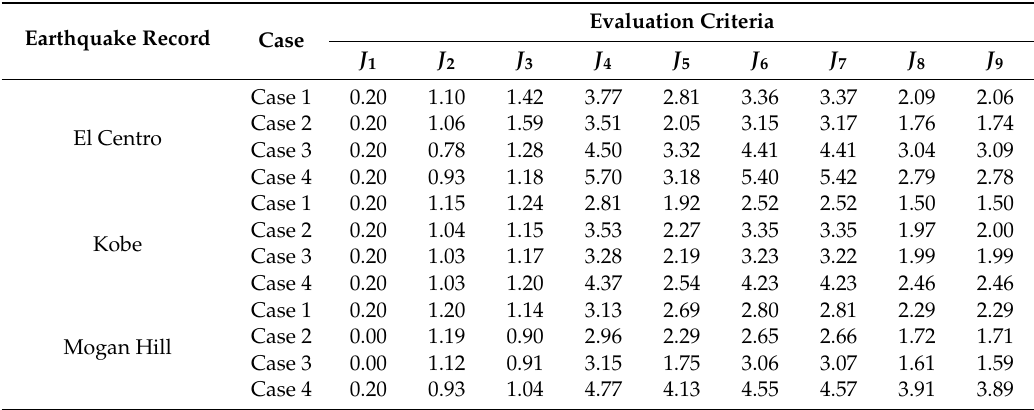
Figure 12. Evolutions of the estimated system model parameters. Table 5. vRTHS evaluation criteria for nominal